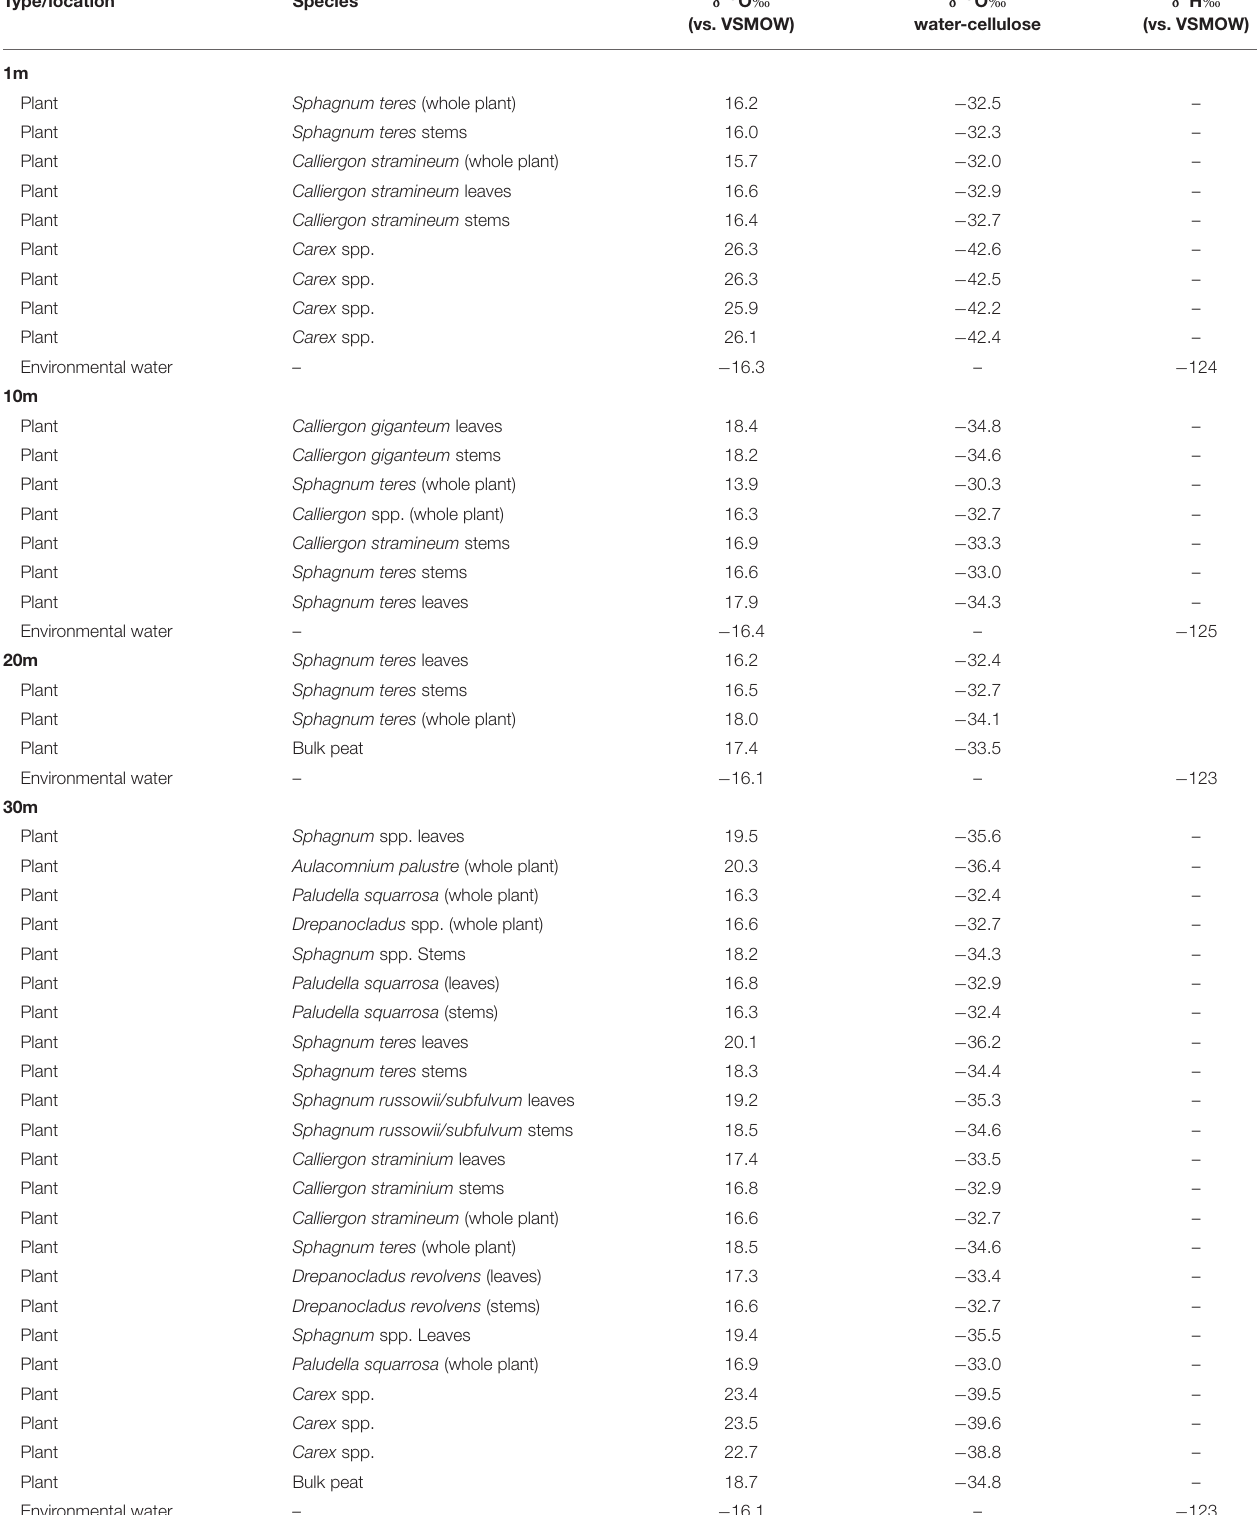
TABLE 3 | Horse Trail fen (HTF) plant cellulose and environmental water isotopes (sampled 7/21/2014).